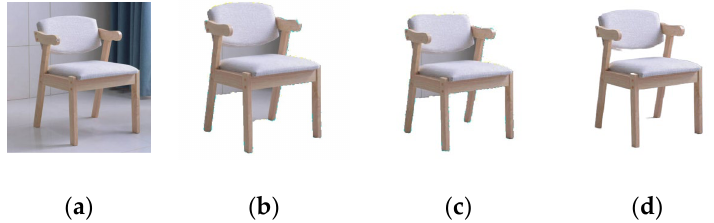
Figure 7. Comparison of different extraction methods. ( a ) Original image ( b ) BC ( c ) GrabCut ( d ) Ours.